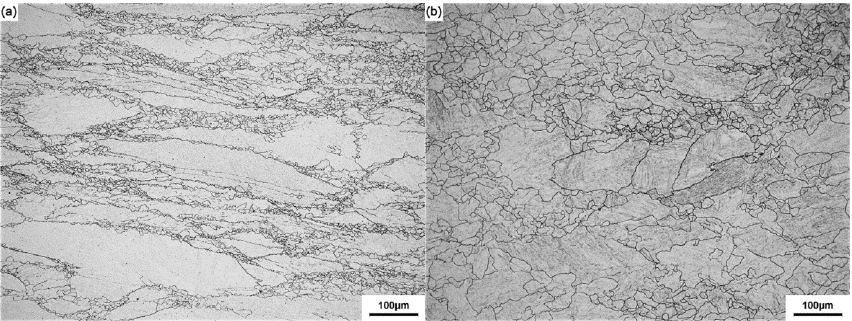
Figure 7. The microstructure of the deformed 30Cr2Ni4MoV steel to a strain of 0.7 at different conditions: ( a ) 850 ◦ C/0.01 s − 1 and ( b ) 950 ◦ C/0.01 s − 1 .